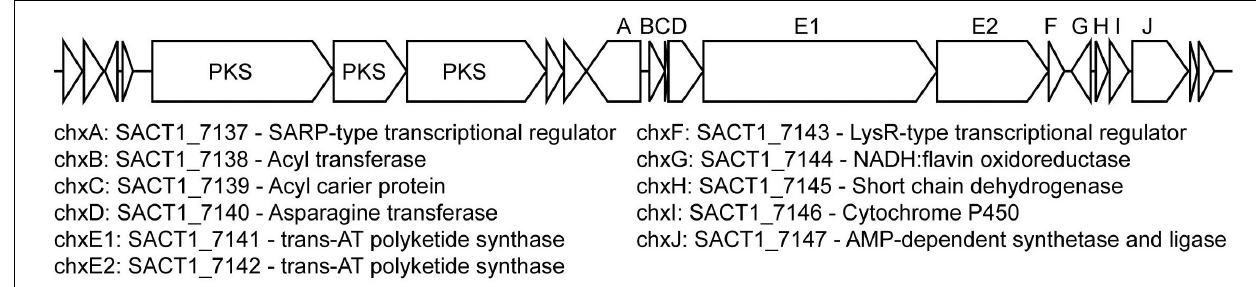
Frontiers in Microbiology |